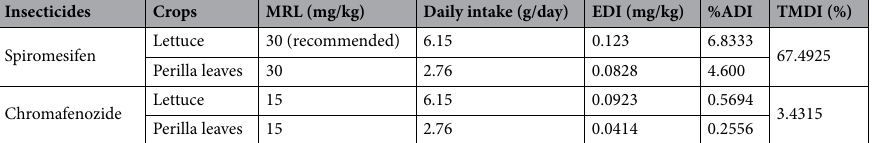
Insecticides Crops MRL